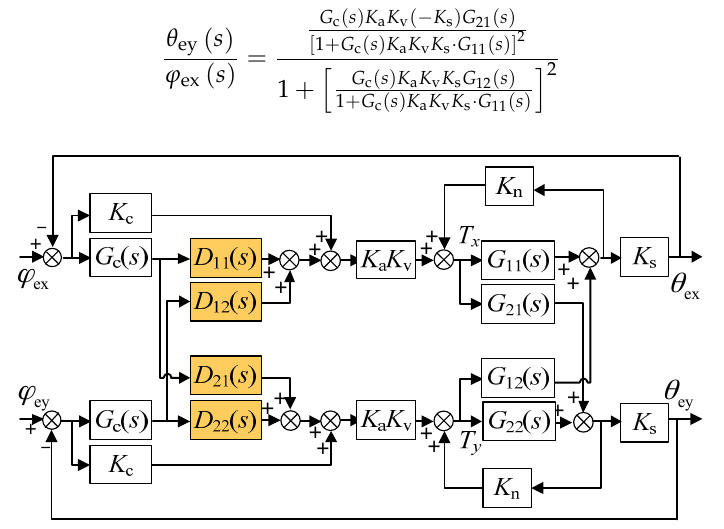
Figure 5. Block diagram of the rebalance loop in verification of the inner-loop decoupling compensation.